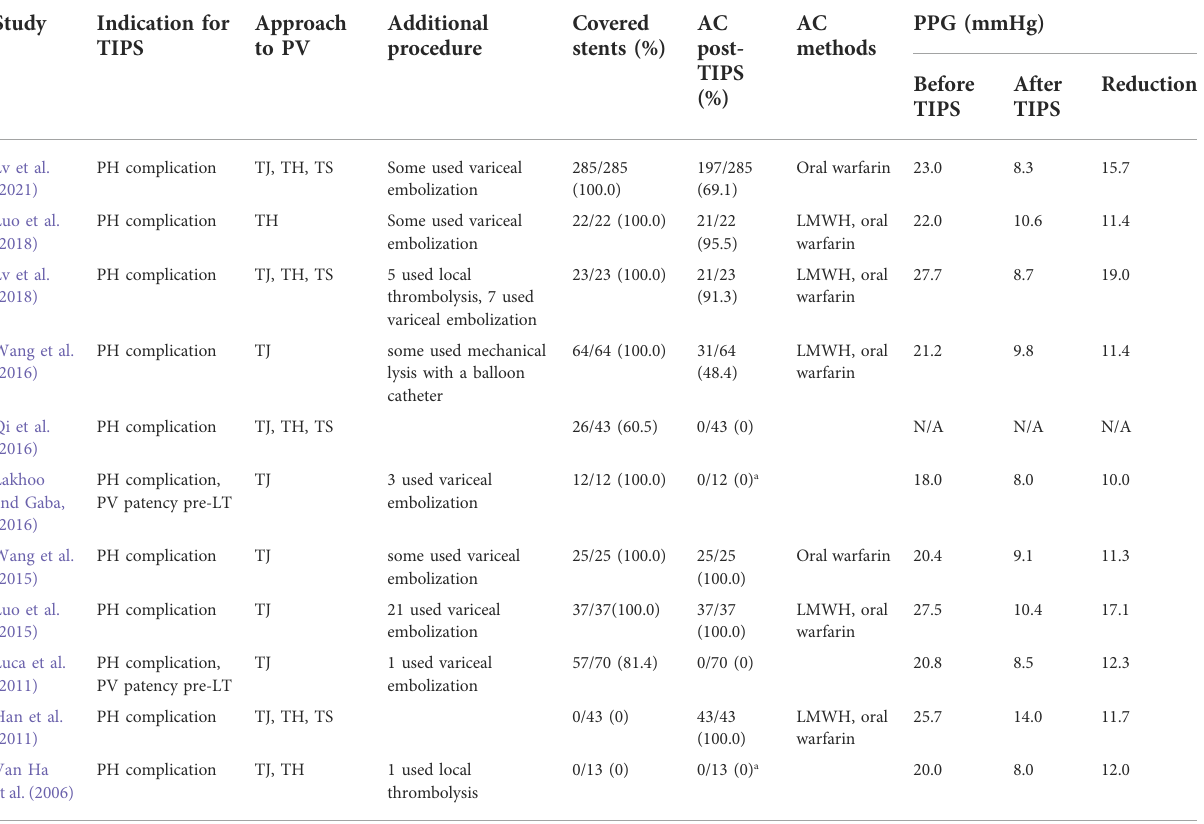
TABLE 2 Characteristics of TIPS